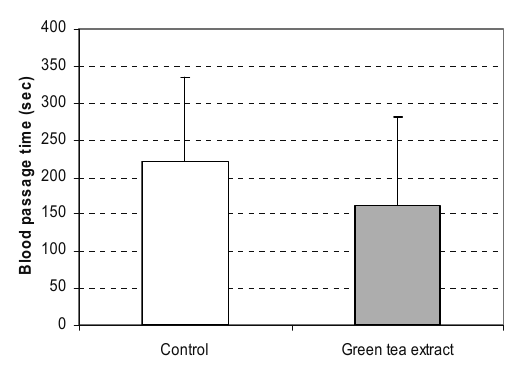
Figure 4. Effect of green tea extract on FFR blood fl uidity measured by Micro- channel array fl ow analyzer (MC- FAN). Green tea extract lowers blood passage time signifi cantly (p <